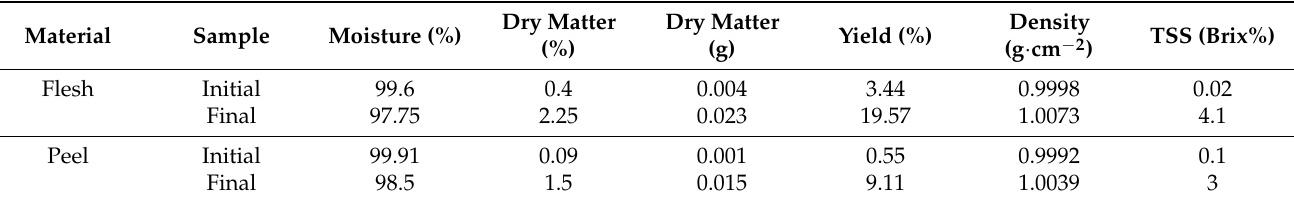
Table 3. Characteristics of the beetroot flesh and peel extracts before and after the concentration by RO membrane (X20).